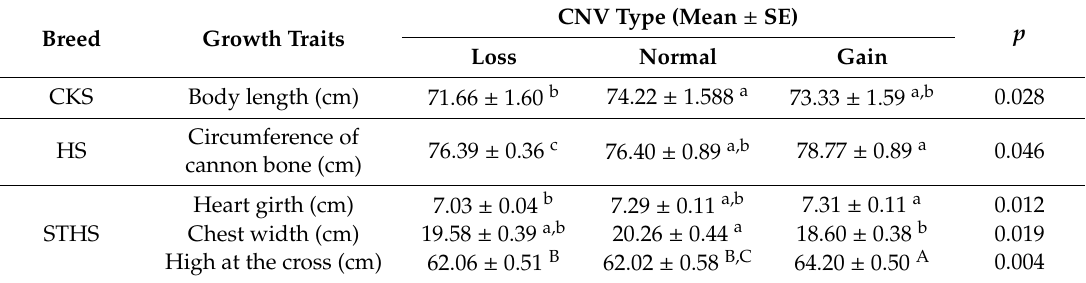
Table 4. Association analysis of the SHE gene CNV with growth traits in four sheep